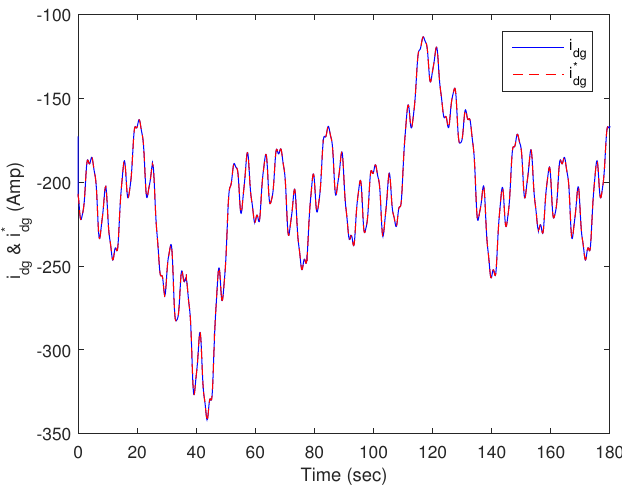
Figure 13. The currents i dg and i ∗